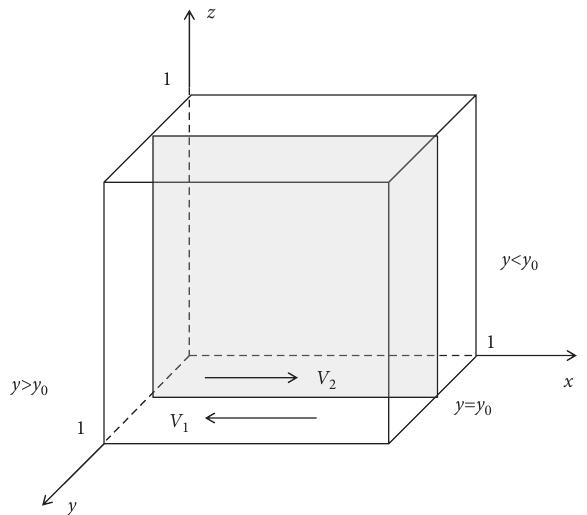
Figure 3: The dynamic trend diagram of regulatory